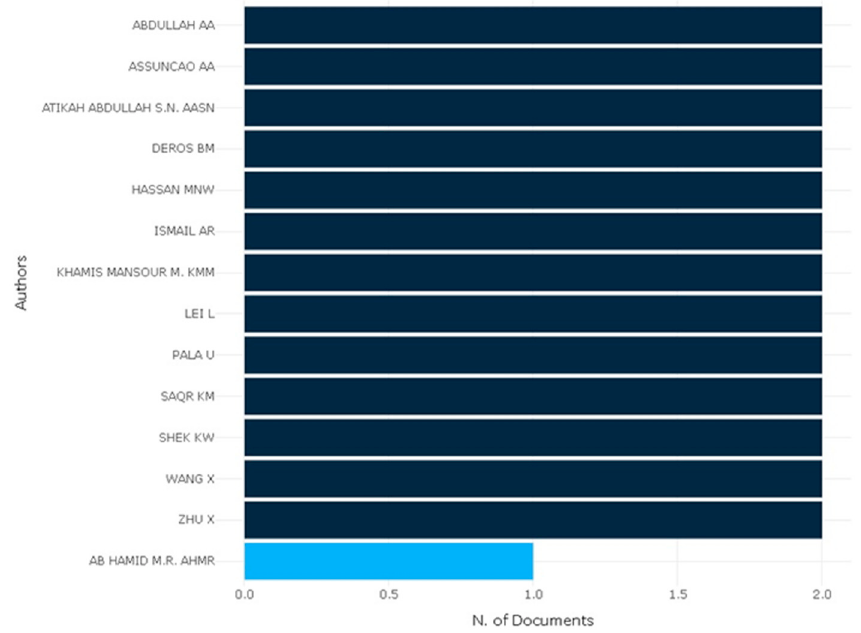
Figure 3. The most relevant authors of thermal comfort studies in bus cabin environments.